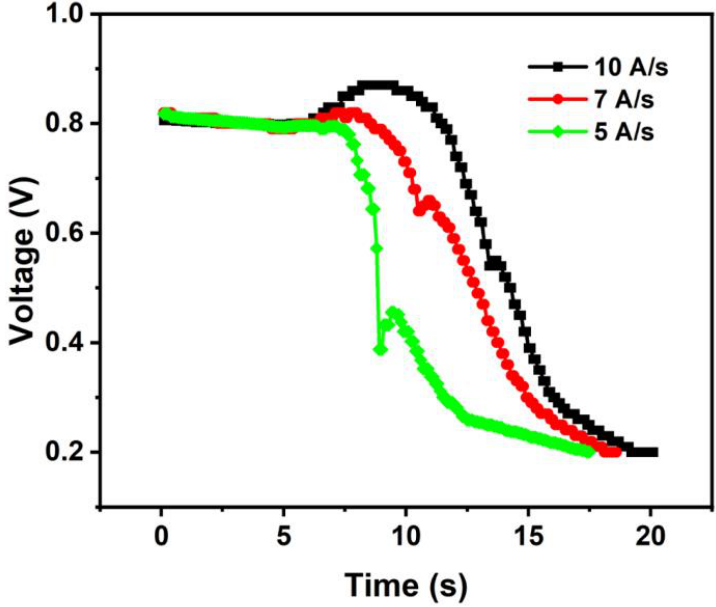
Figure 4. Influence of the different drop rates of the discharge current on the PEMFC shutdown process.